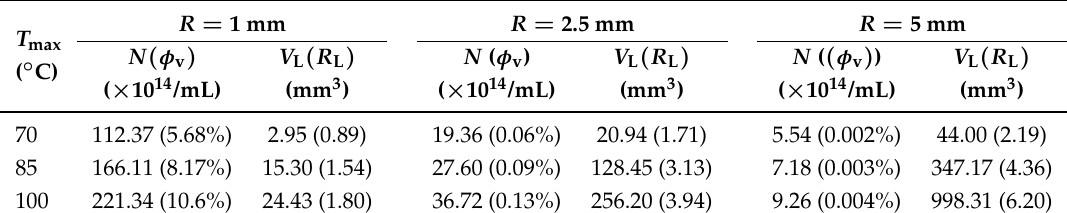
Table 1. Comparison of volume, V L , of predicted lesions and the number density, N , of nanoparticles